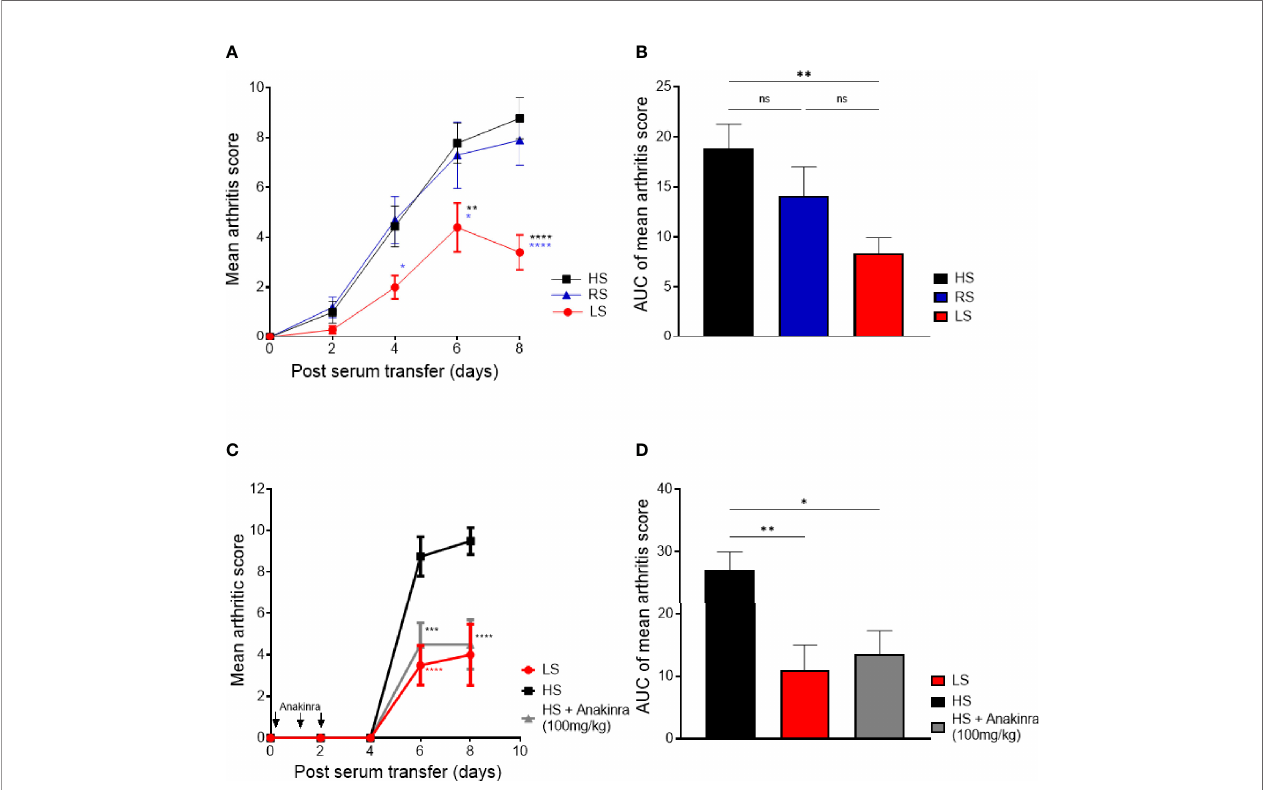
FIGURE 4 | Low-salt diet reduces severity in K/BxN serum transfer-induced arthritis and is as effective as IL-1 receptor blockade. Mice were exposed to low salt (LS), regular salt (RS), and high salt (HS) diets for 2 weeks before serum transfer and continued for further 8 days. (A) Mean arthritis score in STIA mice on different diets (LS, n = 10; HS, n = 10; RS, n = 10). * p < 0.05, ** p < 0.01,**** p < 0.0001; blue asterisk: LS versus RS, black asterisk: LS versus HS. p -values were calculated by two-way ANOVA followed by Bonferroni ’ s multiple comparisons test. (B) Area under the curve of mean arthritis score. ** p < 0.01; ns = non-signi fi cant. p -values were calculated by one-way ANOVA followed by Bonferroni ’ s multiple comparisons test. (C) LS diet is as effective as treatment with IL-1 receptor antagonist protein (anakinra) in HS diet mice. One group of mice under HS diet received i.p. injections of 100 mg/kg anakinra simultaneously with arthritis induction as well as on days 1, 2, and 3 (LS, n = 4; HS, n = 4; HS +Anakinra, n = 4). Red asterisk: LS versus HS, gray asterisk: HS/anakinra versus HS. *** p < 0.001, **** p < 0.0001. p -values were calculated by two-way ANOVA followed by Bonferroni ’ s correction. (D) Area under the curve of mean arthritis score of STIA mice undergoing LS diet, HS diet, and HS plus